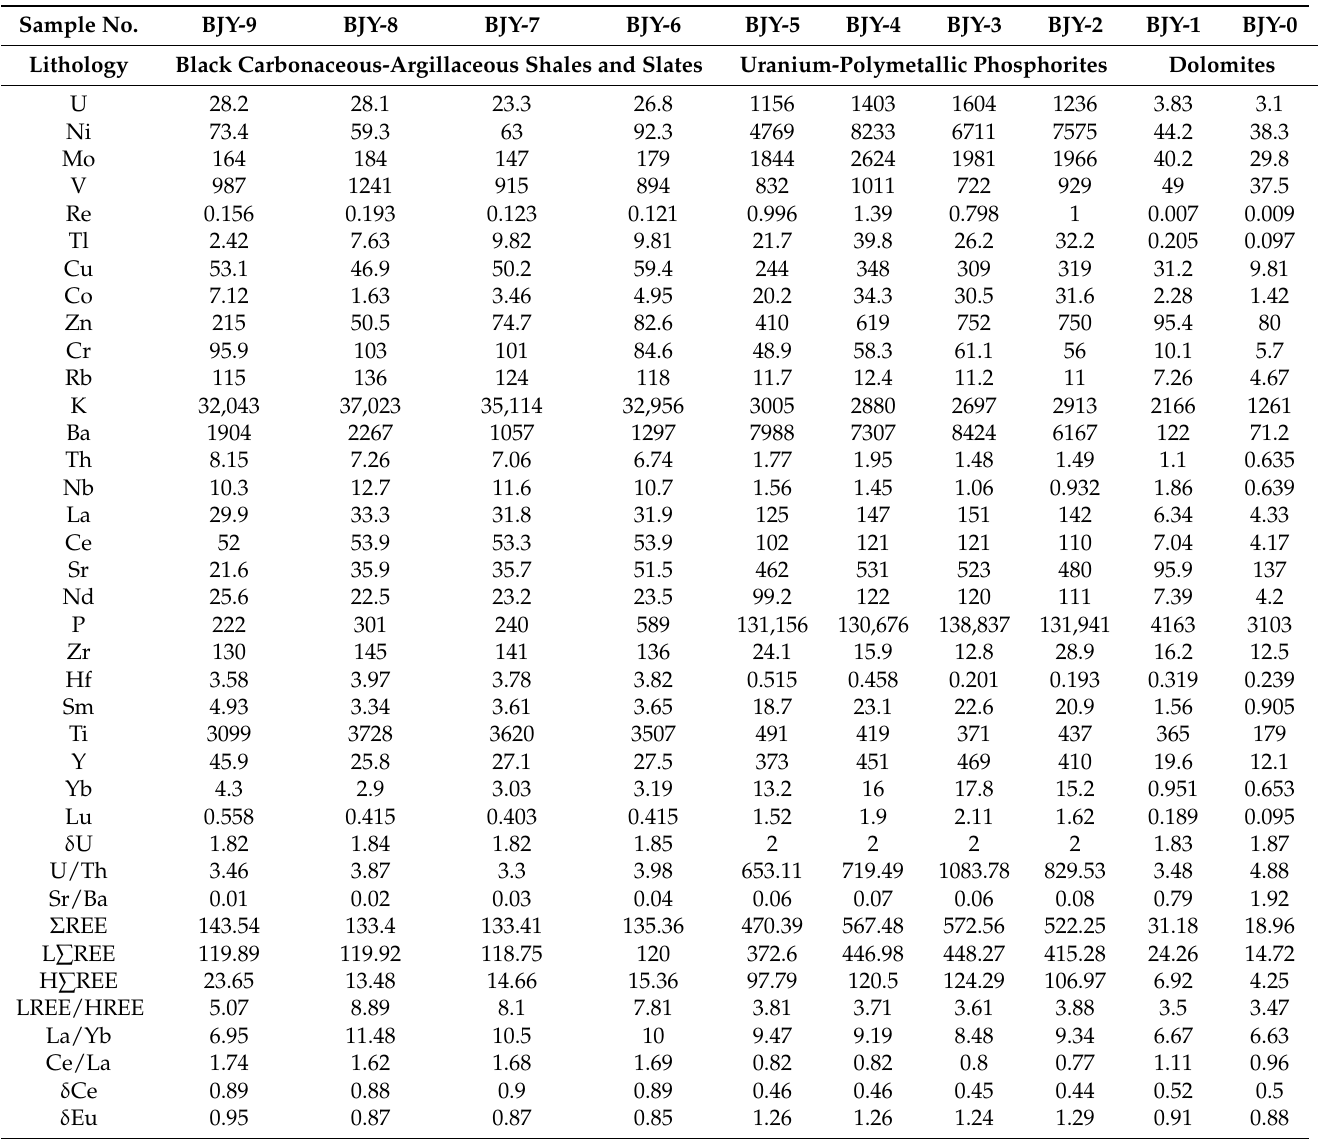
Table 2. The analytical results of the trace elements and rare earth elements in the Baizhuyu deposit (w B /10 − 6